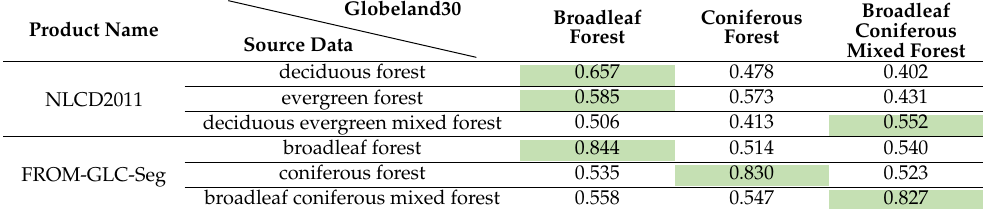
Table 8. Comprehensive mapping